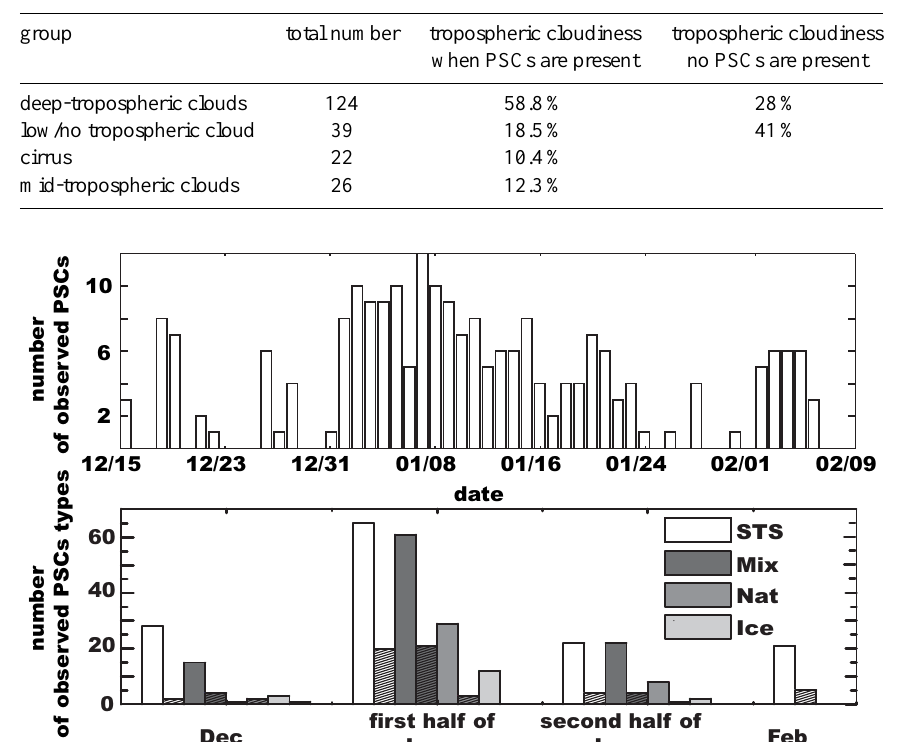
Table 1. Number of different tropospheric cloud types observed concurrent to the 211 PSCs detected by the CALIPSO lidar during winter 2007/2008. For comparison, the table also gives the number of deep-tropospheric clouds and low/no clouds for which no PSCs were observed.